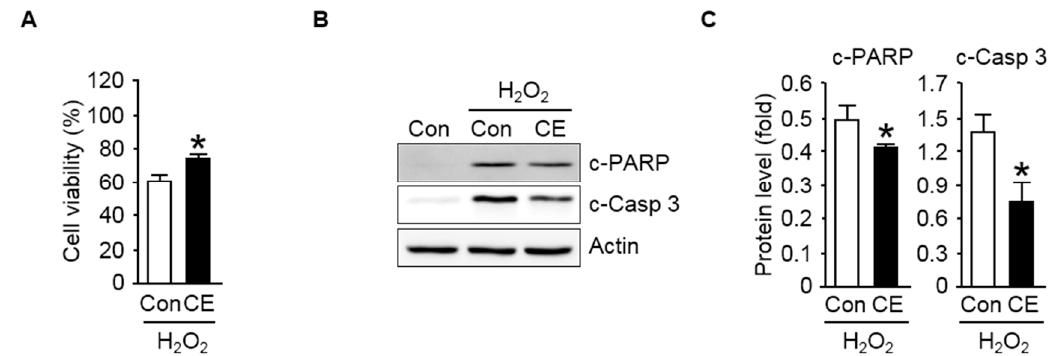
Figure 2. Protective effect of CE against oxidant-induced cytotoxicity in NCI-H460 human lung cells. ( A ) The viability of untreated (Con, control) NCI-H460 cells and cells treated with 0.5 mg/mL CE upon exposure to 250 μ M H 2 O 2 for 24 h was evaluated by the MTT assay. Values are represented as the mean ± S.D. from three separate experiments. * p < 0.05 compared with H 2 O 2 -treated cells; ( B ) immunoblot analysis of apoptosis-related proteins. The cell extracts were electrophoresed on 8–12% SDS-polyacrylamide gels, transferred to nitrocellulose membranes, and immunoblotted with antibodies against cleaved poly (ADP-ribose) polymerase (c-PARP) and cleaved caspase 3 (c-Casp 3). Actin was used as the internal control; ( C ) quantifications of the levels of c-PARP and c-Casp 3 normalized to actin are shown. Data are represented as the mean ± S.D. from three independent experiments. * p < 0.05 compared with the H 2 O 2 -treated group.